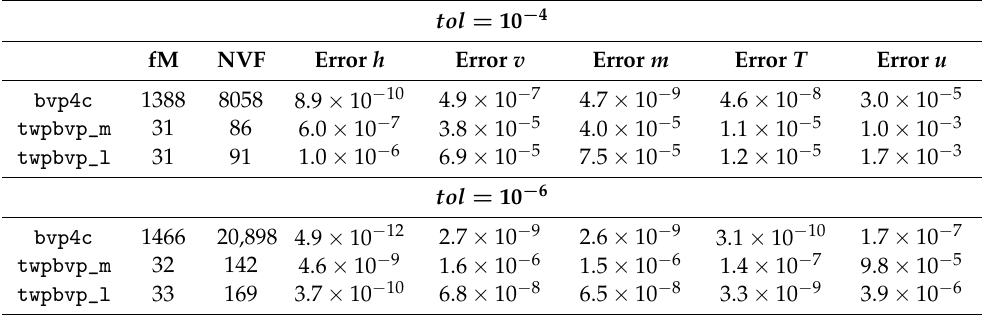
Figure 5. Goddard rocket, (cid:101) = 10 − 3 , ¯ σ = 10 − 4 : from left to right solutions in time for altitude h and mass m (on the top ), for velocity v and thrust u (on the bottom ). Table 18. Goddard Rocket problem (15) solved using a piecewise quadratic penalty function with ¯ σ = 10 − 4 and (cid:101) = 10 − 3 : final mesh (fM), total number of vectorized function evaluation (NVF) and mixed errors for h , v , m , T and u